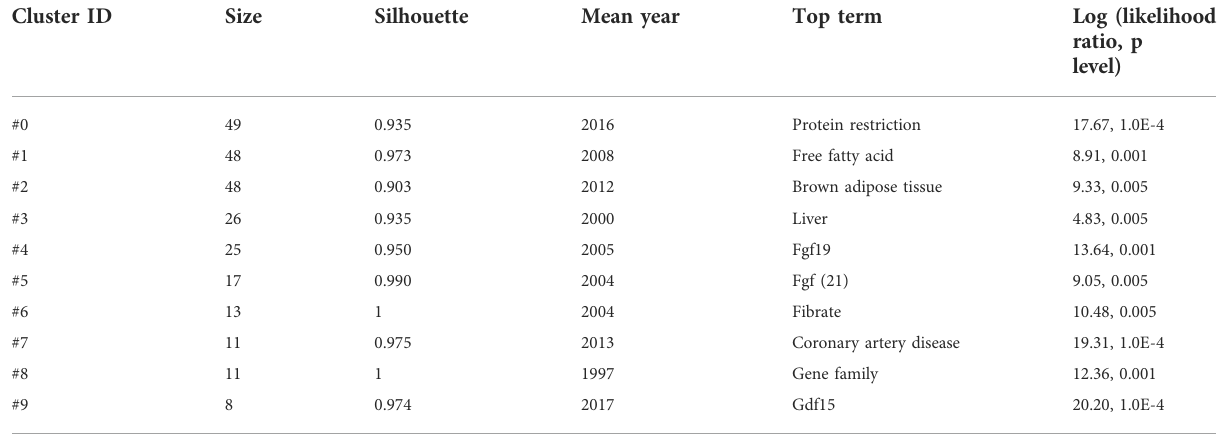
TABLE 6 Top ten clusters of co-cited references with the highest K